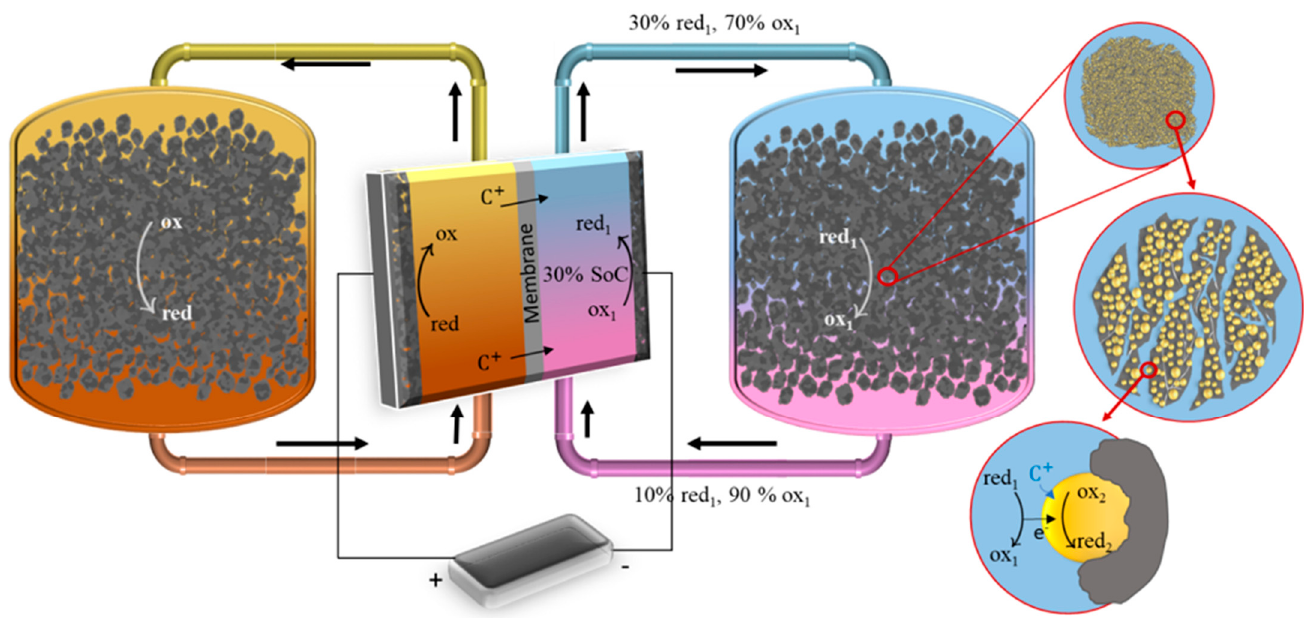
Figure 1. Overview of the solid booster system in a redox flow battery over multiple scales. Solid boosters are deposited in the tank as millimeter-sized porous beads, containing the redox active solid materials (ox 2 /red 2 (yellow) for negative side), and conductive additive and binder (grey). In this example, on the negative side of the battery discharged electrolyte ox 1 /red 1 is reduced in the cell from SoC of 10% to 30%. Reduced dissolved species will then react in the tank to reduce the solid active material ox 2 /red 2 . This reaction is typically accompanied by intercalation of a cation C + . Similar reactions take place at the positive side.